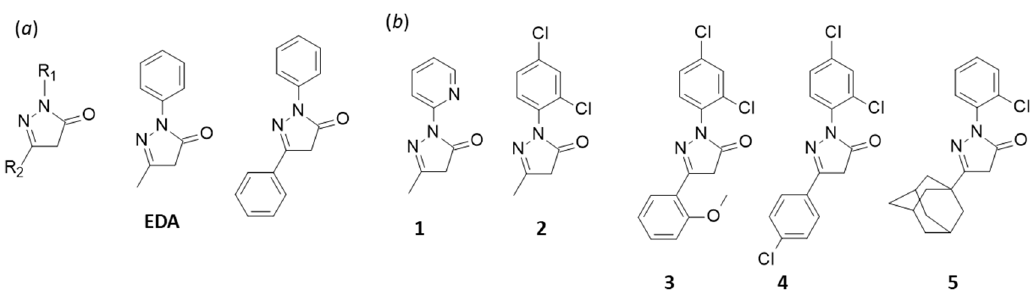
Figure 1. ( a ) Structure of edaravone (EDA), the pyrazolone central core and the